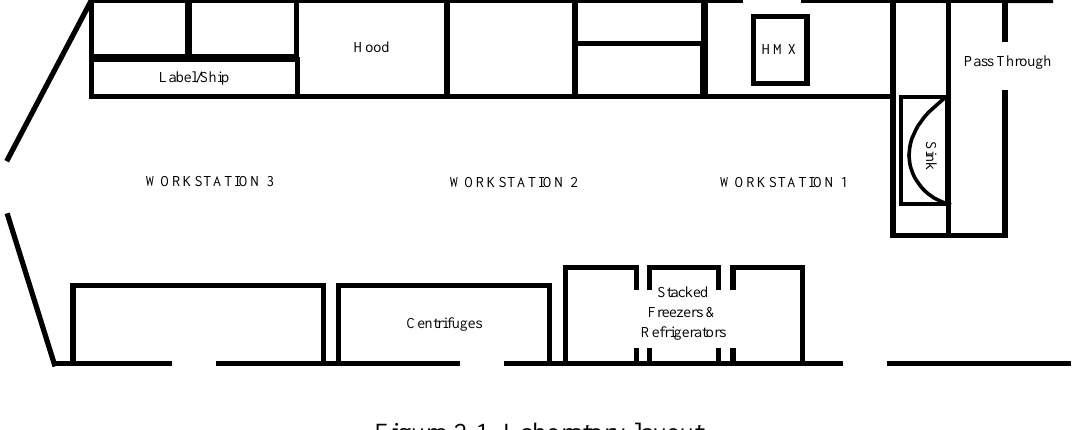
Figure 2-1. Laboratory layout